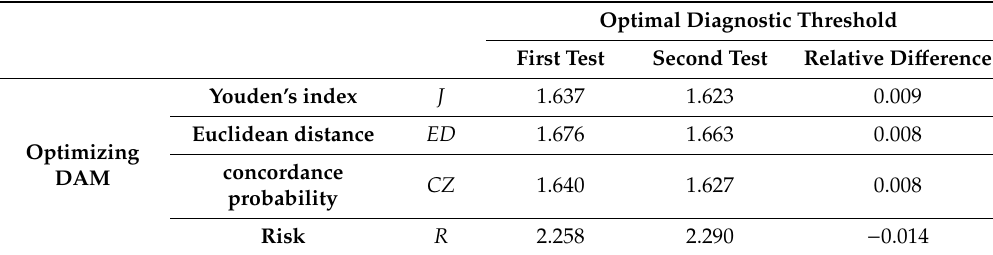
Table 5. Optimal diagnostic